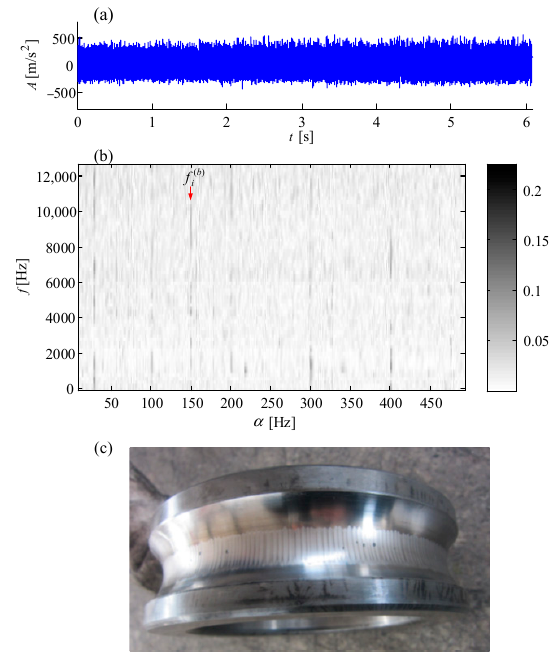
Figure 29. Vibration analysis of a faulty bearing signal: ( a ) faulty vibration signal polluted by elec- tromagnetic vibration; ( b ) cyclic coherence function of the vibration signal; ( c ) faulty inner race of the bearing.